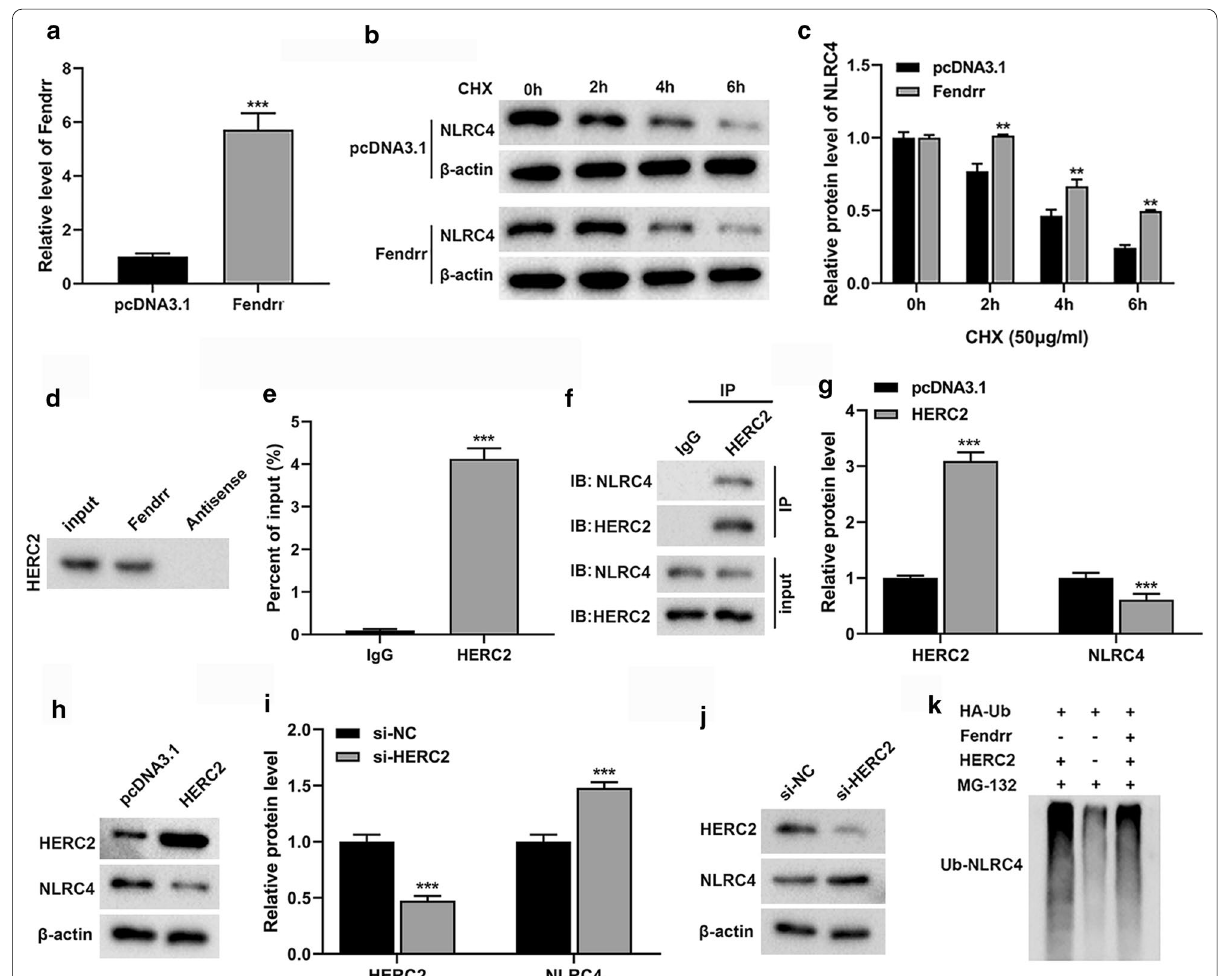
Fig. 3 LncRNA‑Fendrr may regulate the ubiquitination of NLRC4 protein through HERC2. a The expression of Fendrr was detected by qRT‑PCR. b , c After transfection, the cells were treated with Cycloheximide (CHX) (50 μg/mL) for 0, 2, 4 and 6 h, and the NLRC4 protein level was detected through western blot. d , e The binding of lncRNA Fendrr to HERC2 protein was detected by ( d ) RNA pull‑down and ( e ) RNA Immunoprecipitation (*** P < 0.001 versus the IgG group). f The interaction between HERC2 and NLRC4 was detected by Co‑Immunoprecipitation. g , h pcDNA3.1‑HERC2 or pcDNA3.1 (control) was transfected into BV‑2 cells, and then HERC2 and NLRC4 were detected by Western blotting. i , j si‑HERC2 or si‑NC (control) was transfected into BV‑2 cells, and then HERC2 and NLRC4 expressions were detected by Western blotting. k BV‑2 cells were treated with MG132 (10 μg/mL) and transfected or co‑transfected with pcDNA3.1‑Fendrr and pcDNA3.1‑HERC2 to detect NLRC4 ubiquitination levels. n are presented as means SD. P values were analyzed by Student’s t‑test. ** P < 0.01 and *** P < 0.001 versus the pcDNA3.1 ±